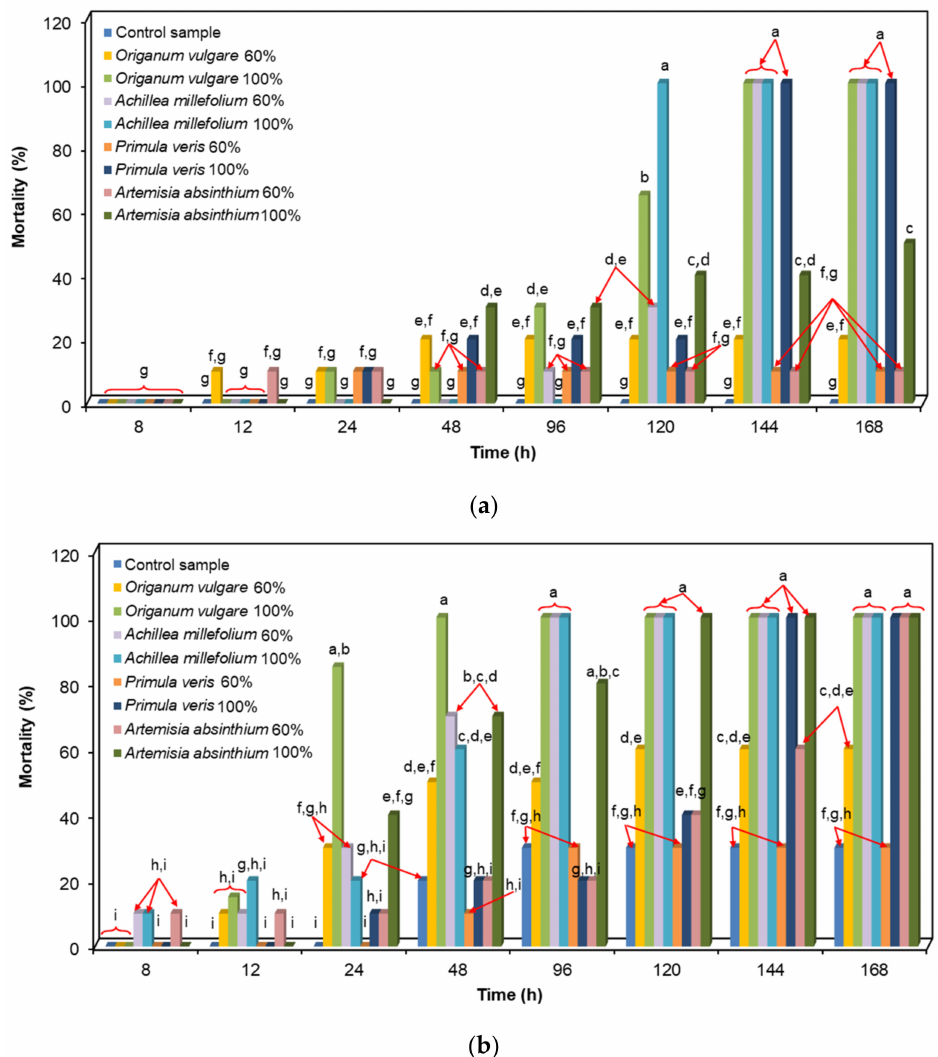
Figure 5. Results of statistical analysis on mortality (%) of Leptinotarsa decemlineata species: ( a ) adults and ( b )